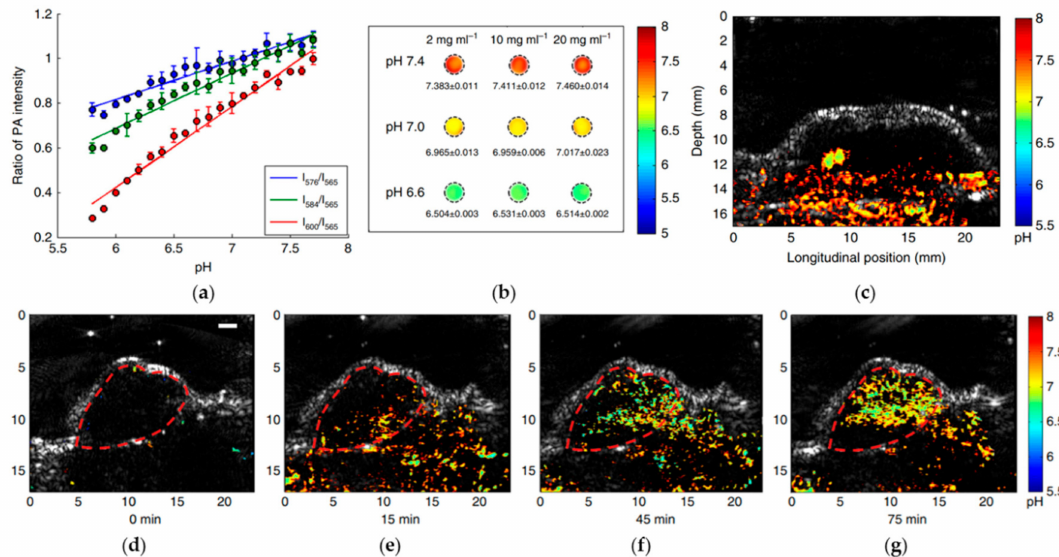
Figure 10. ( a ) Measured ratio of PA intensity ratios between the three wavelengths and the isosbestic point from pH 5.8–7.7; ( b ) auantitative pH images of phantoms containing different concentrations (6.6, 7.0 and 7.4); ( c ) PA pH image of a normal tissue; ( d – g ) auantitative PA pH images at different time points after nanoprobe injection. Reprinted with permission from